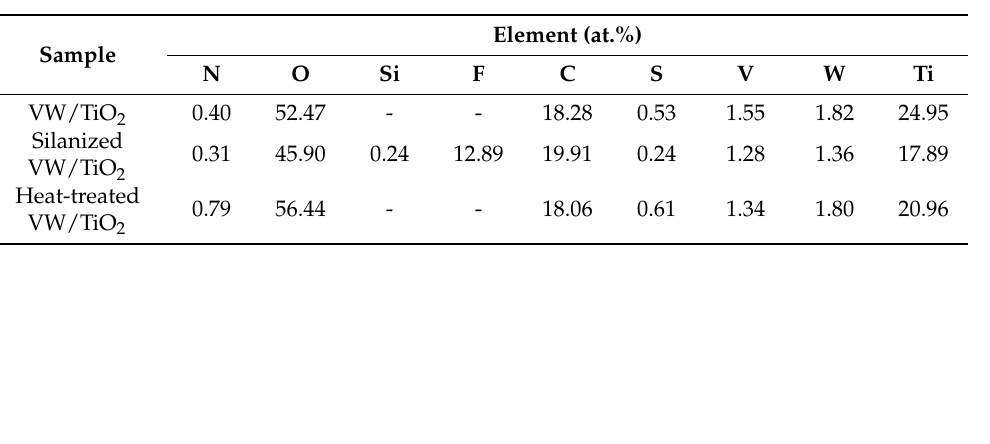
Table 2. Atomic percent of element obtained from XPS spectra of the V 2 O 5 -WO 3 /TiO 2 ,